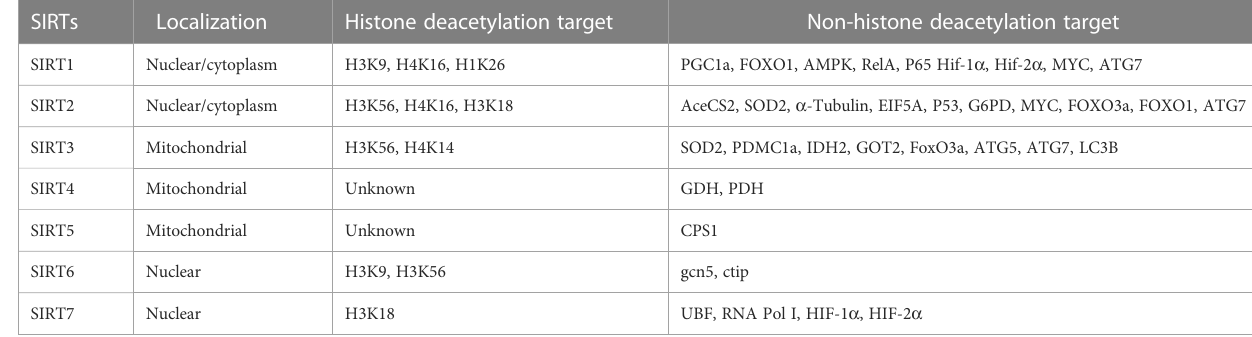
TABLE 1 The localization and targets of